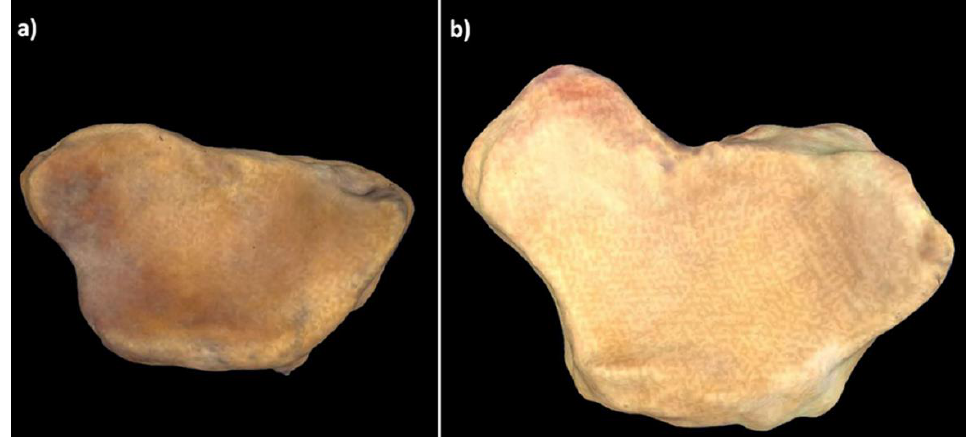
Figure 3. Distal view of the carpal articular surface of radius in ( a ) a gorilla with low allometric effect and ( b ) a gorilla with great allometric effect. A marked displacement of the palmar margin of the lunate fossa can be observed in ( b ).